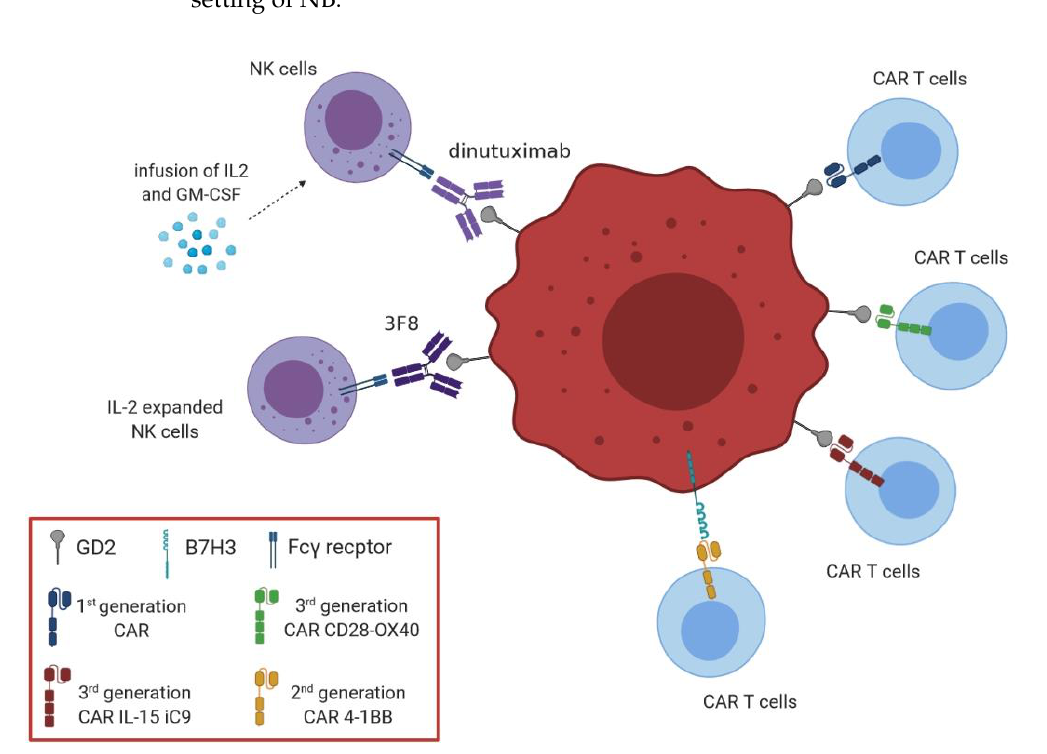
Figure 2. Current adoptive cell therapies in the clinical setting of neuroblastoma (NB) treatment. This figure describes different adoptive cell therapy approaches currently investigated for immunotherapy of high-risk NB patients. This includes CAR T cells and NK cells as adjuvant therapy, used alone or in combination with cytokines. Cytokines may also be used to expand NK cells before infusion.